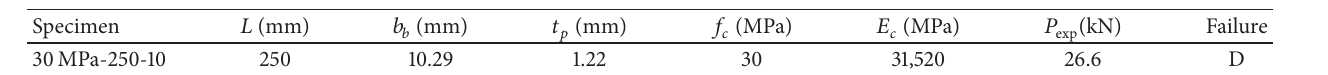
Table 2: Summary of testing results.